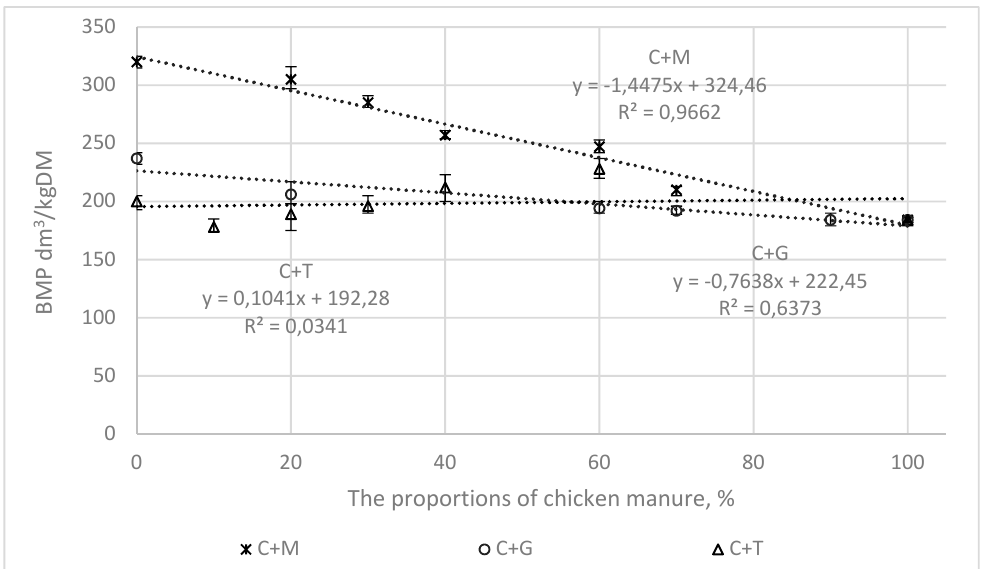
Figure 3. The correlations between the BMP and the proportions of chicken manure in the mixtures with co-substrates.